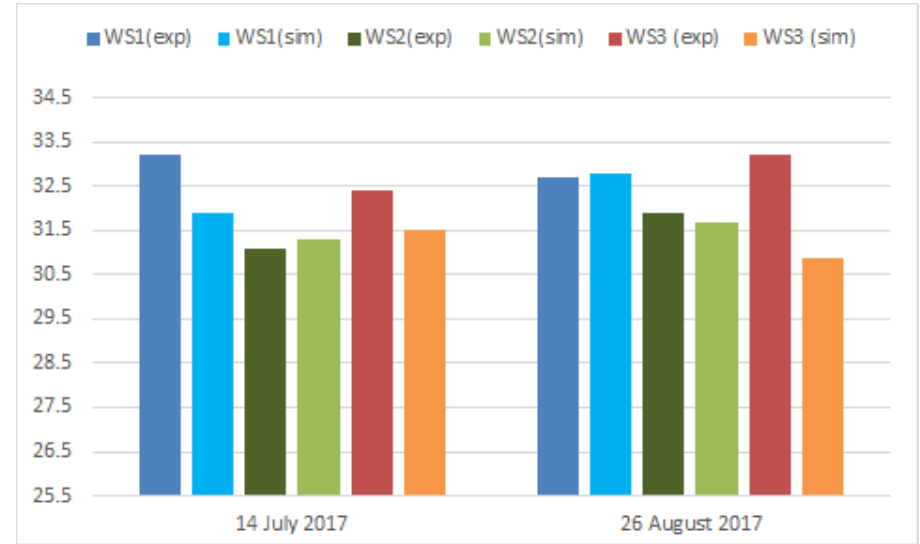
Figure 10. Observed (exp) and calculated (sim) atmospheric temperature (Tmax) at the three weather stations site (WS1, WS2, WS3 as) on 14 July and 26 August 2017. stations site (WS1, WS2, WS3 as) on 14 July and 26 August 2017.